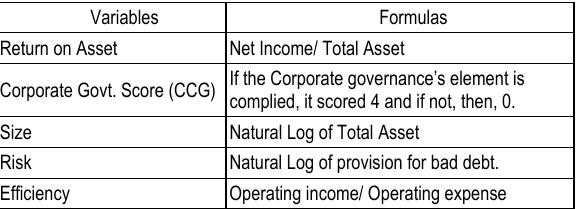
Table 1. Variables and respective formulas